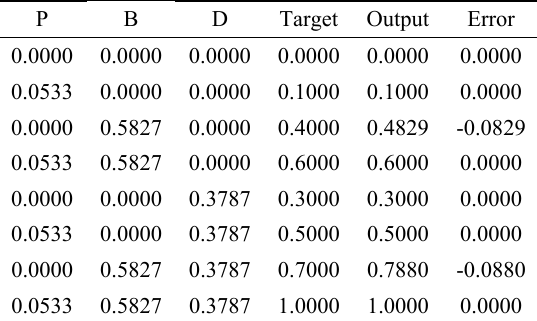
Table 8: Input values, target values and the corresponding output and error values generated by an artificial neural network information fusion technique using term weight identity attributes metrics values.